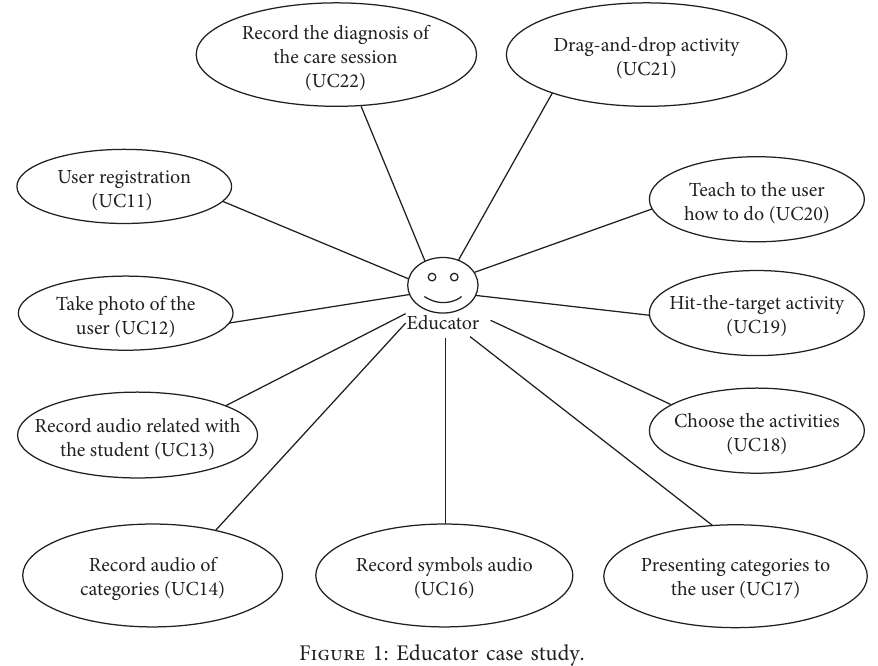
Figure 1: Educator case study.